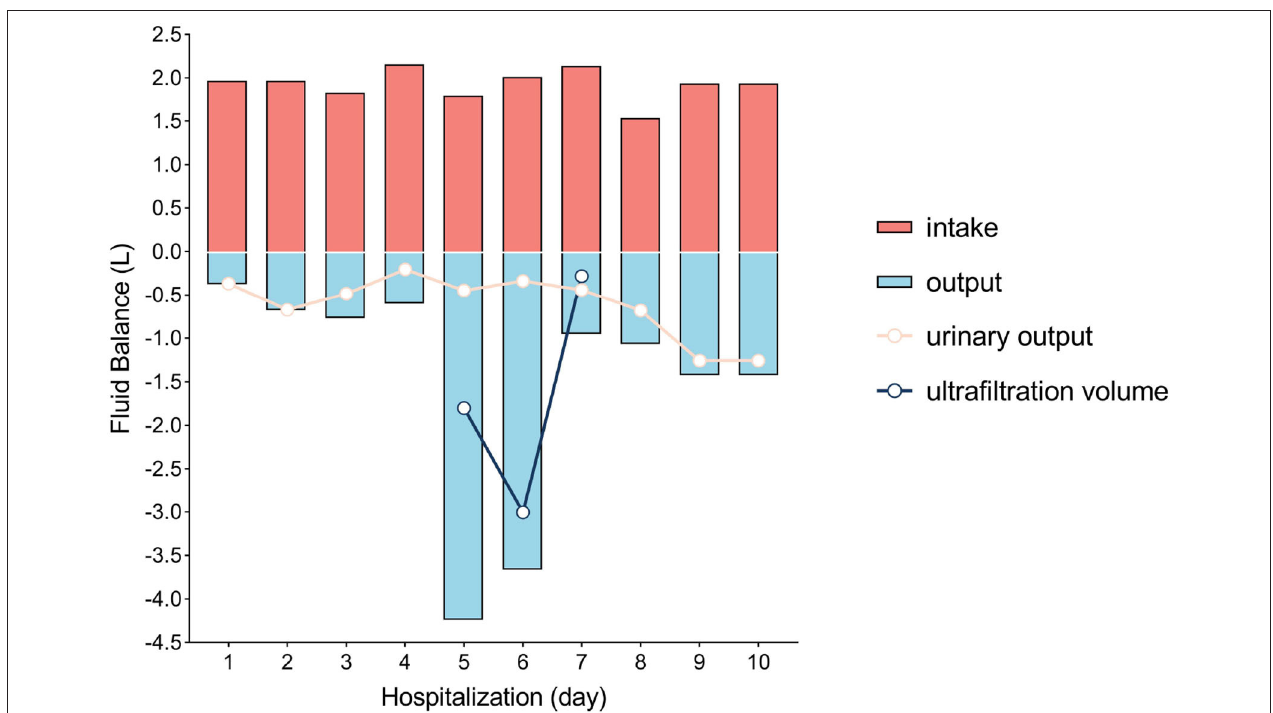
FIGURE 1 | Fluid balance in the first 10 days of hospitalization. Day 1 was defined as the time between hospital admission and the next morning (14h).